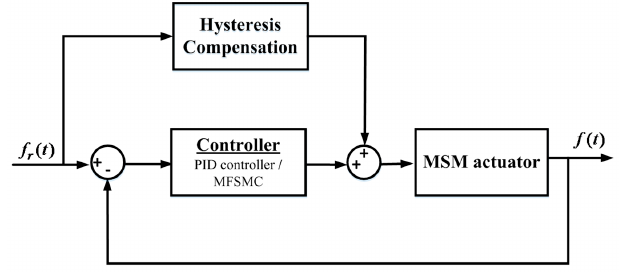
Figure 10. Block diagram of novel controller design by combining path controller and the hysteresis